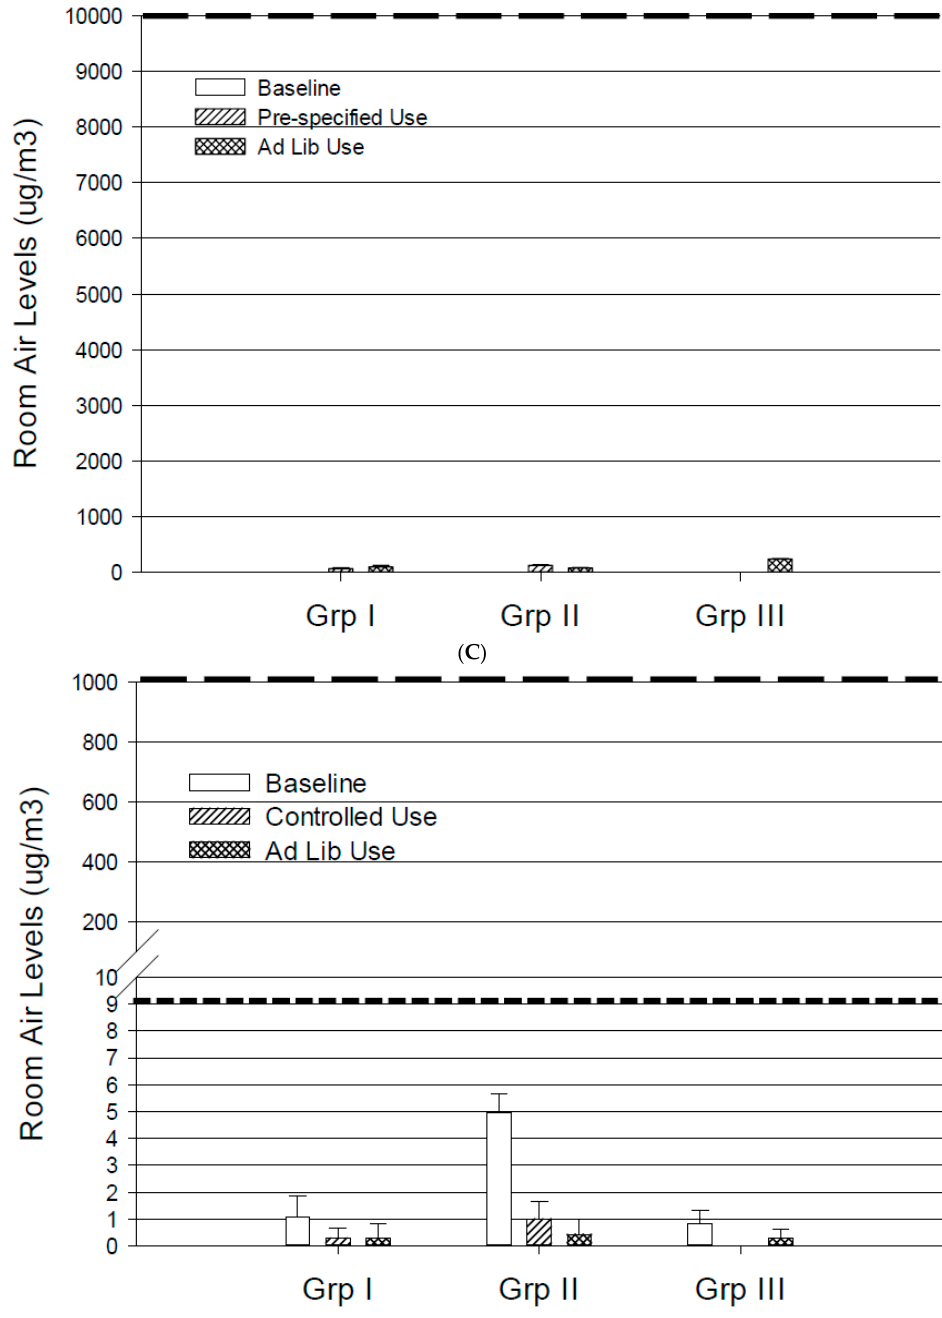
Figure 3. Mean levels of nicotine ( A ); propylene glycol ( B ); glycerol ( C ) and formaldehyde ( D ) in RAS at baseline and from the use of the two EVPs (Groups I and II) and the tank product (Group III) over four hours of use. The dashed lines represent limits for air contaminants set by various agencies (value shown as 8-h time weighted average permissible exposure limit); nicotine: Occupational Safety and Health Administration (OSHA) limit of 500 μ g/m 3 ; PG: American Industrial Hygiene Association (AIHA) limit of 10,000 μ g/m 3 (wide dashed lines) and Office of Environmental Health Hazard Assessment, California Environmental Protection Agency (OEHHA) limit of 7000 μ g/m 3 (narrow dashed lines); glycerol: OSHA limit of 10,000 μ g/m 3 ; and formaldehyde: OSHA limit of 980 μ g/m 3 (wide dashed lines) and OEHHA limit of 9 μ g/m 3 (narrow dashed lines).